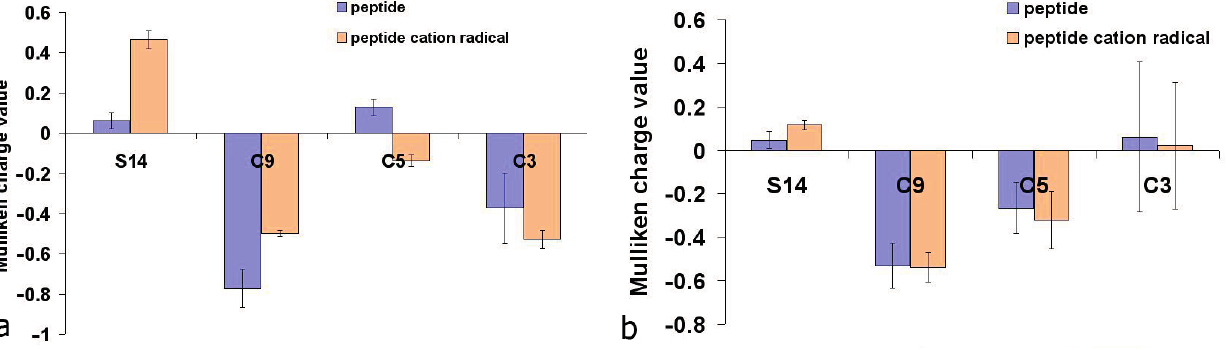
Figure 8. Average Mulliken charge values on sulfur and carbon atoms of methionine residues at C-terminal ( a ) and N-terminal ( b ) position in